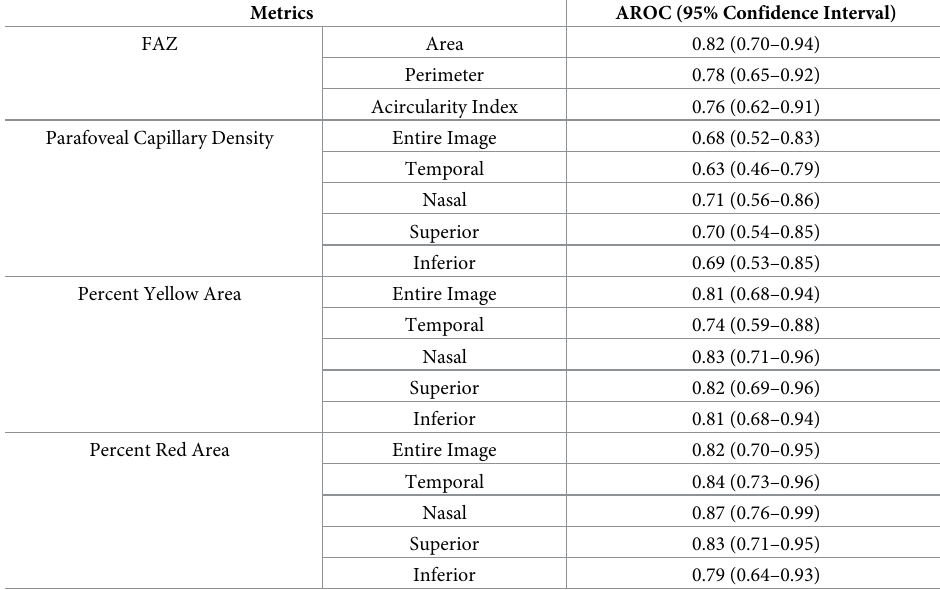
Table 2. Area under receiver operating characteristic curve.